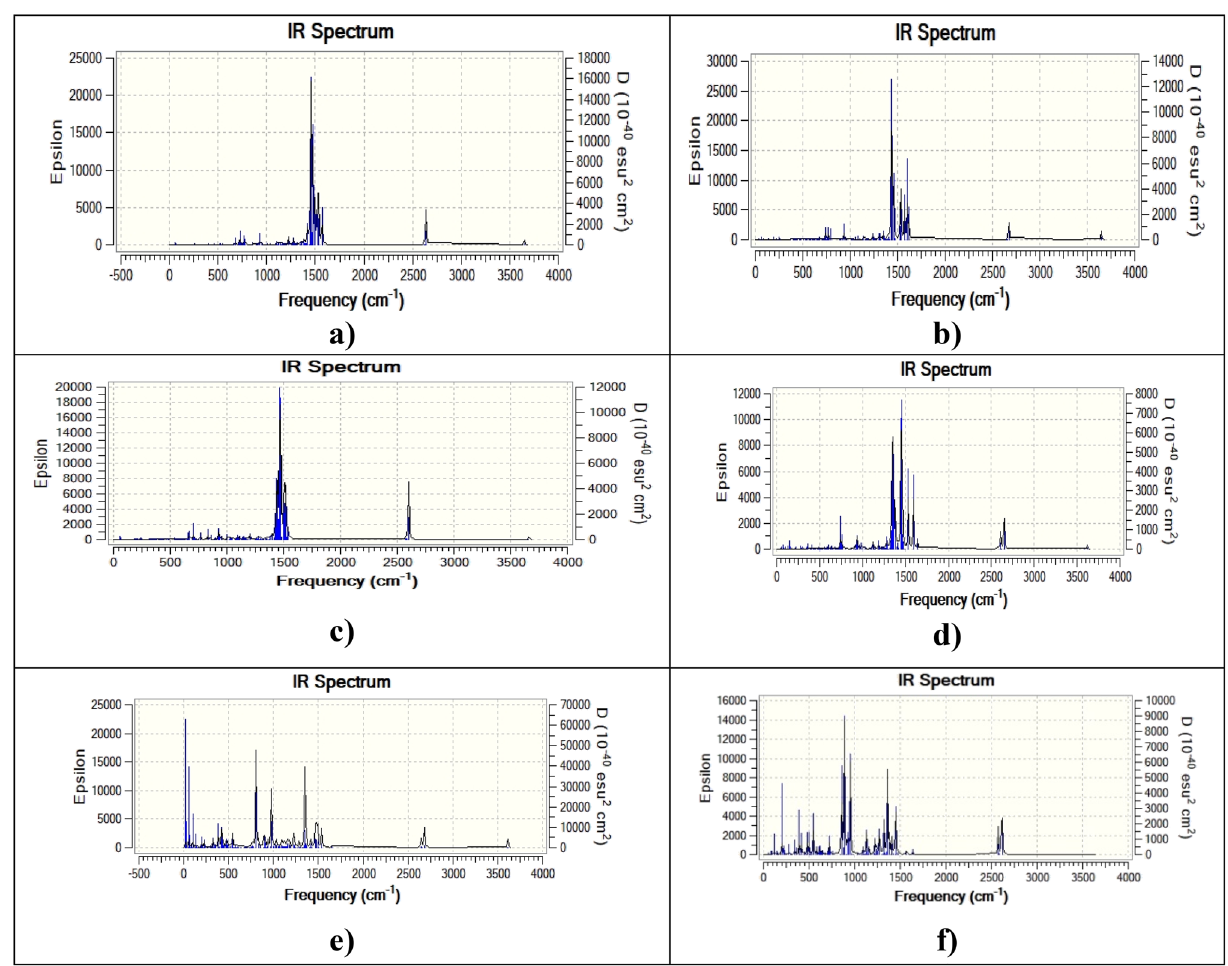
Fig. 2 Vibrational spectrum for nanosheets with neutral, cation and anion charge, a , b , c B